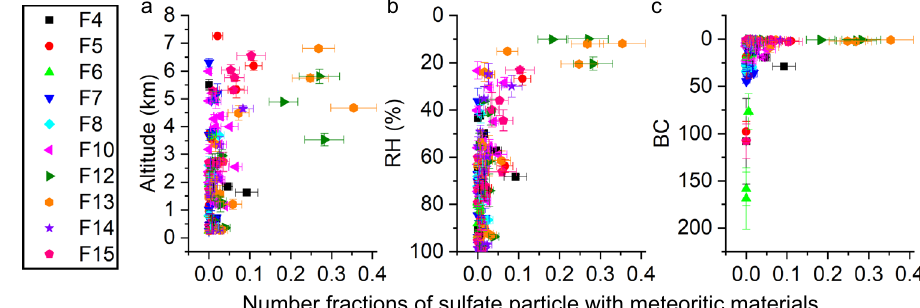
Fig. 5 Relationship between the number fraction of sulfate particles with meteoritic materials and observed parameters. Observed parameters are a altitude, b relative humidity (RH), and c black carbon (BC) concentrations (particle number per cm 3 at standard temperature and pressure) at the sampling points. Plot colors and symbols indicate different fl ight (F) numbers. The numbers of samples from each fl ight used for TEM were 11, 12, 10, 11, 6, 20, 13, 18, 17, and 17 for F4, F5, F6, F7, F8, F10, F12, F13, F14, and F15, respectively. Errors for Y -axes are shown at the 95% con fi dence interval, and those for number fractions are based on Poisson statistics.